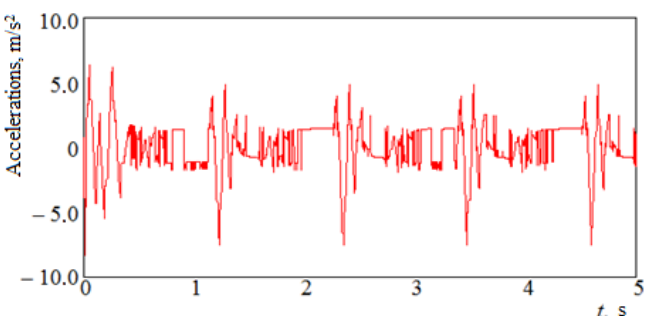
Figure 14. Acceleration of the hopper-wagon-bearing structure in the areas of support on the bogies.